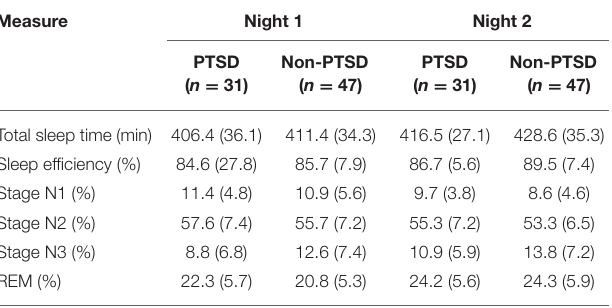
TABLE 2 | Sleep architecture measures for subjects with and without PTSD during two consecutive nights of sleep at the University of Pittsburgh sleep laboratory. Measure Night 1 Night 2 PTSD Non-PTSD PTSD Non-PTSD ( n = 31) ( n = 47) ( n = 31) ( n =